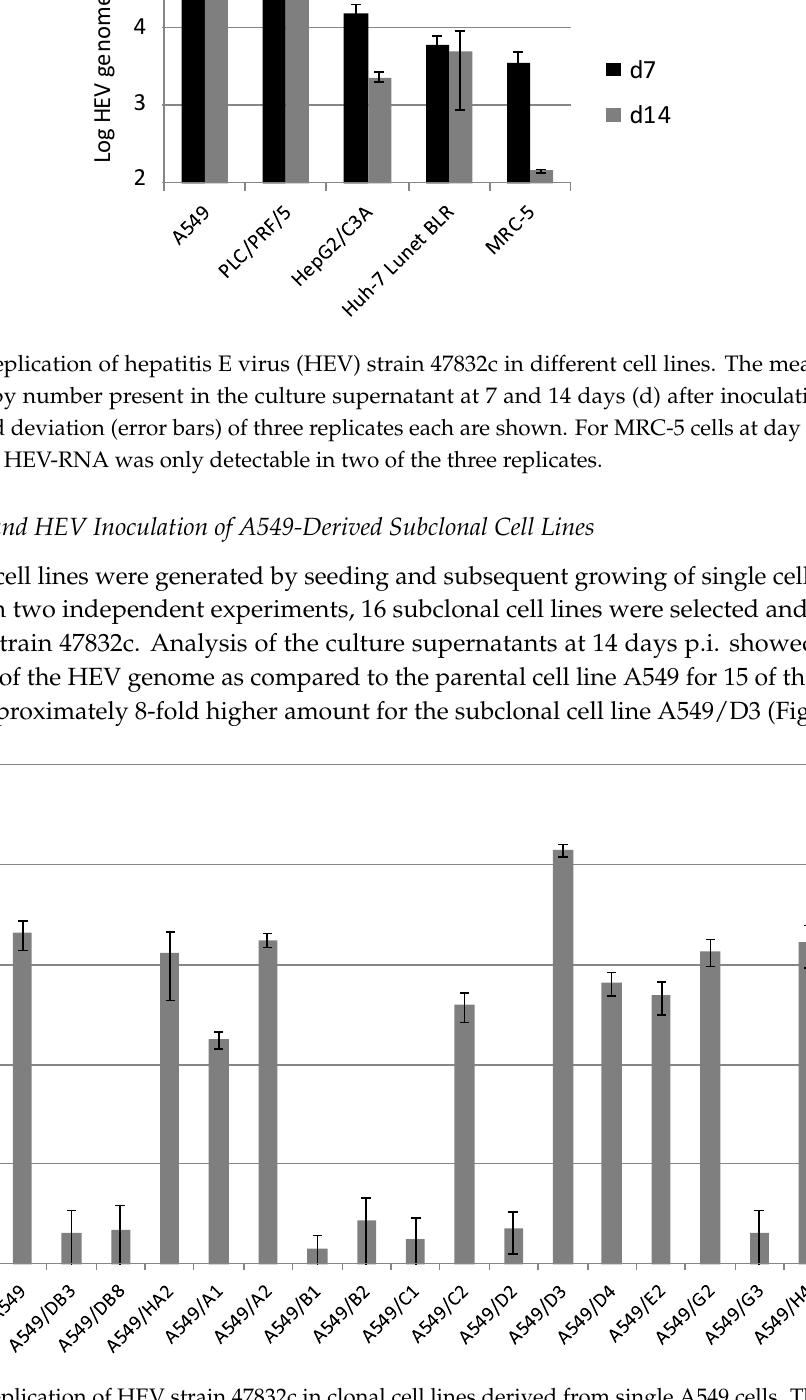
Figure 2. Replication of HEV strain 47832c in clonal cell lines derived from single A549 cells. The HEV genome copy number present in the culture supernatant at 14 days after infection and the standard deviation (error bars) of three replicates each are shown.